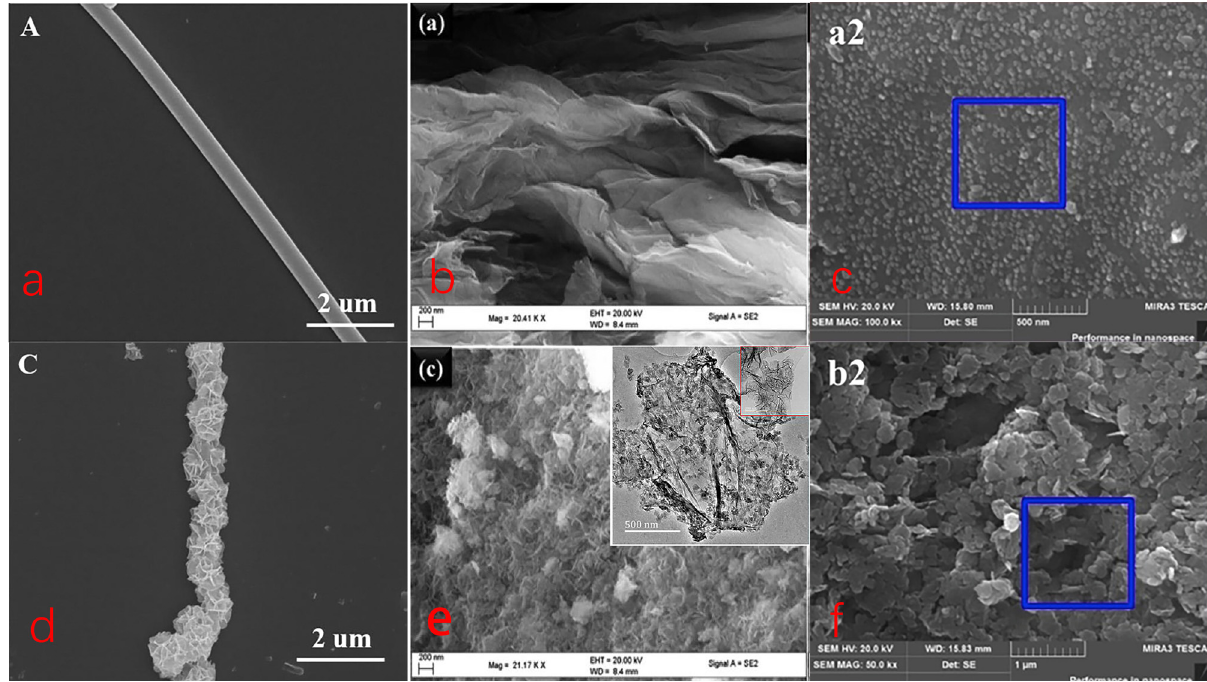
Figure 7: Microstructure of substrate and LDH loaded on substrate: ( a ) carbon nano fi ber; ( d ) LDH loaded on carbon nano fi ber [ 100 ] ; ( b ) graphene; ( e ) LDH loaded on graphene [ 107 ] ; ( c ) biochar; and ( f ) LDH loaded on biochar [ 108 ]